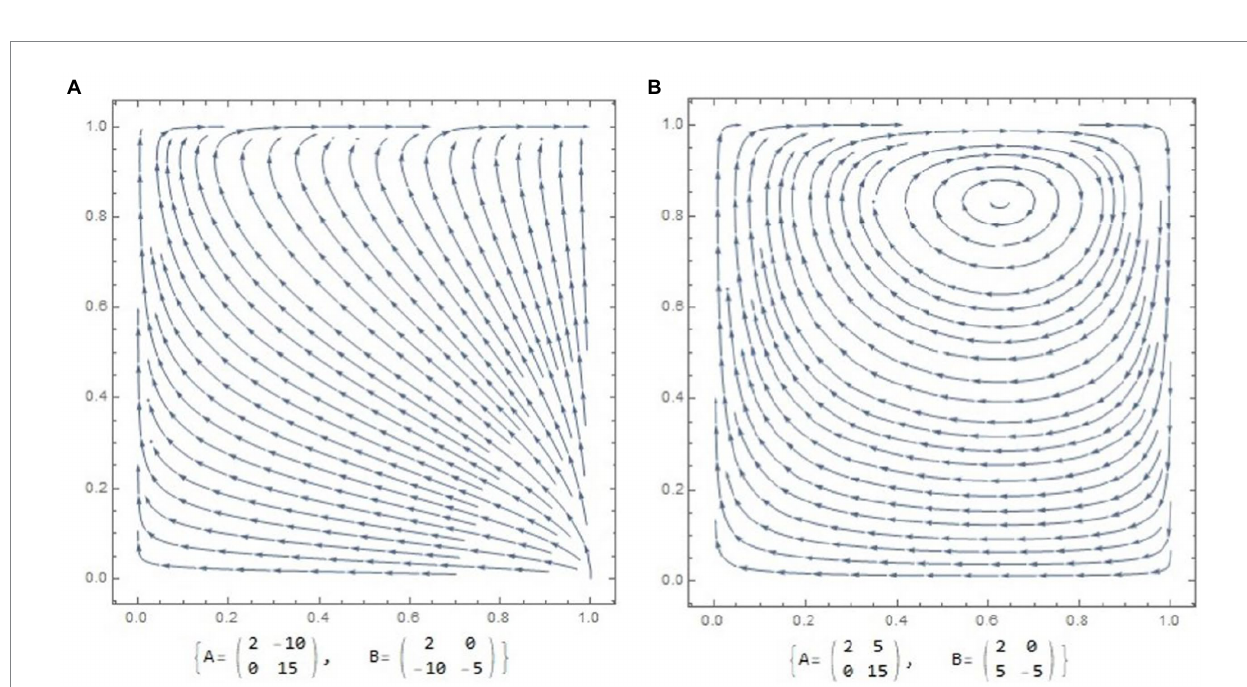
FIGURE 2 Phase portrait and corresponding payoff matrices for males and females. The arrowheads depict evolutionary trajectories. (A) selection favors cooperative parental strategies; hence population evolves toward the equilibrium state–biparental care. While male populations would be specifically selected against male-only care practice. (B) Phase portrait of dynamical forces, describing battle of the sexes according to payoff matrix proposed by R. Dawkins. The model leads to endless